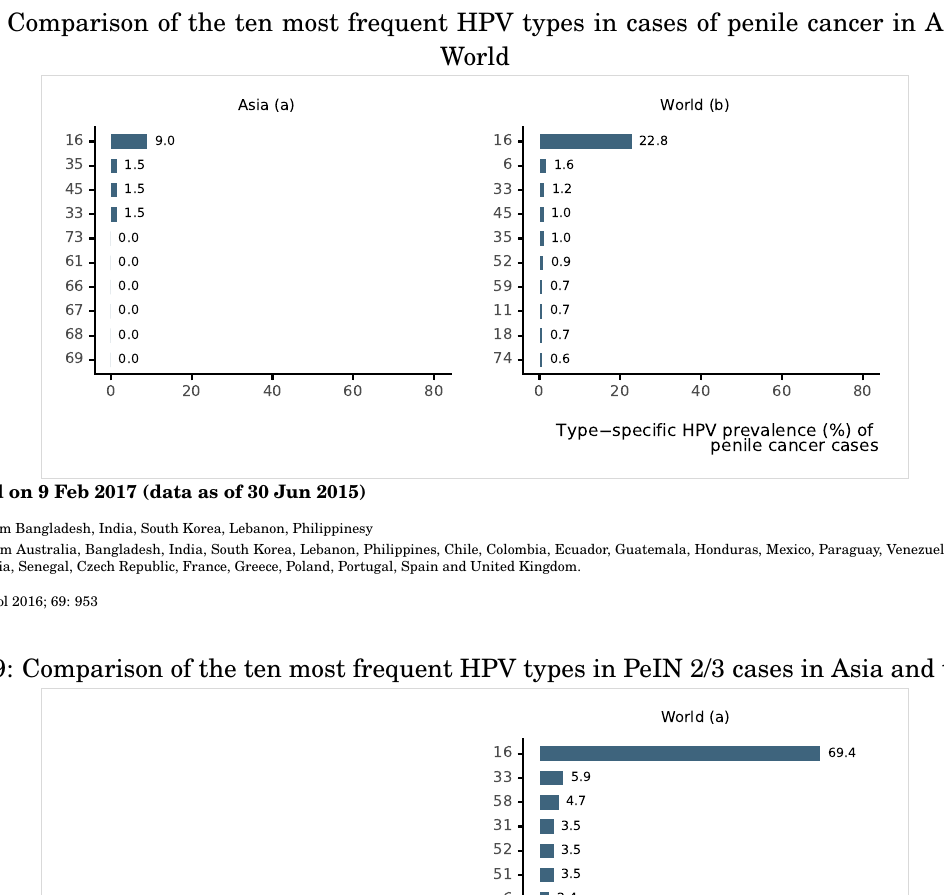
No data available